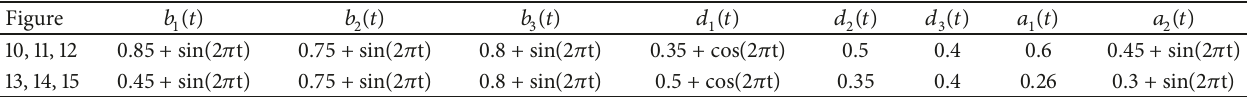
Table 1: Parameters used in Experiment